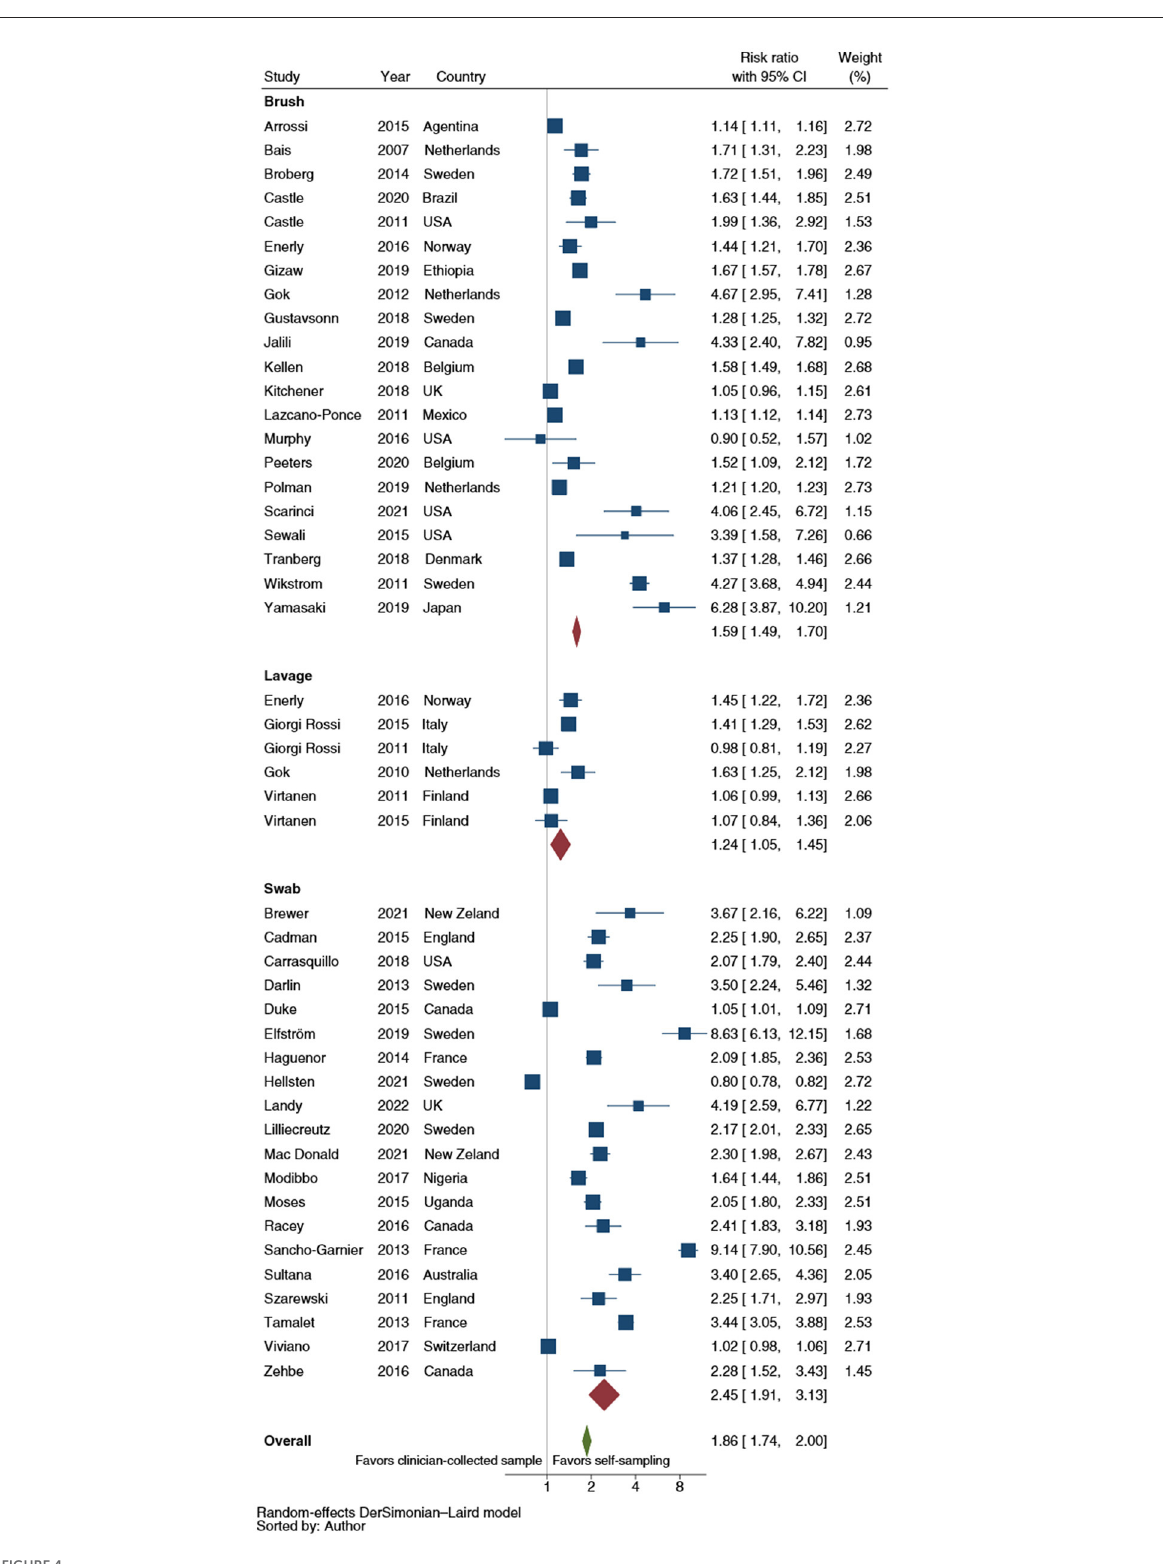
FIGURE4 Forest plot comparing cervical cancer screening (CCS) uptake for HPV testing by self-sampler types vs. clinician-collected samples. Homogeneity ( I -squared): 98.8%; Cochrane’s Q test for between-group differences: Q = 3,904.90; df = 2; p =